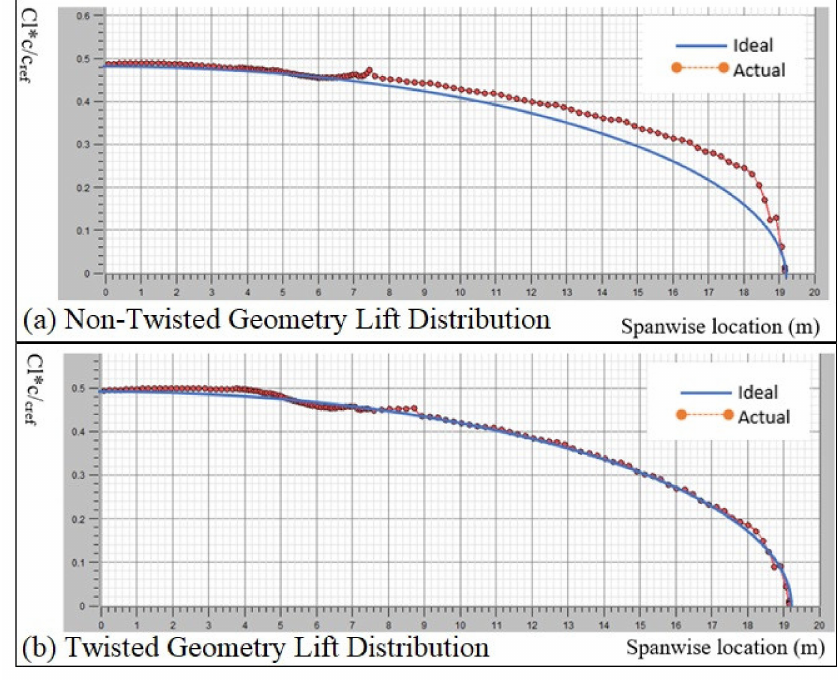
Figure 4. Spanwise lift distribution at cruise